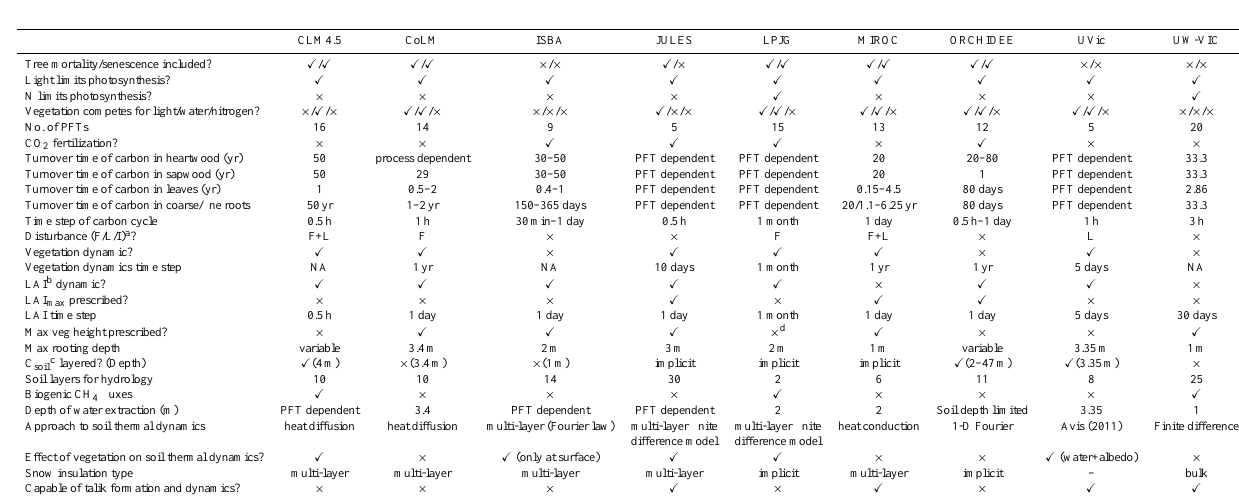
Table 2. Properties in each model relevant to simulation of land-atmosphere CO 2 dynamics, particularly for the northern high latitude terrestrial biosphere. Properties are indicated as present ( (cid:88) ), absent ( × ) or otherwise (see footnote for details).